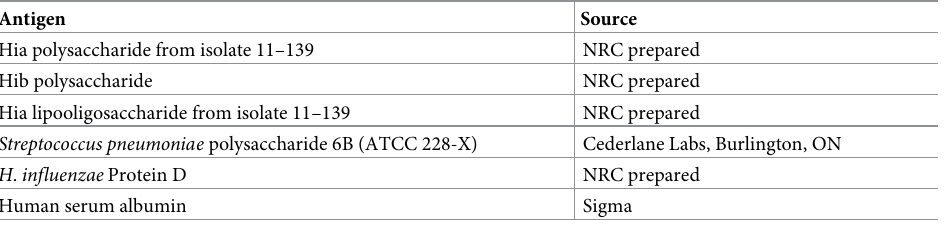
Table 3. Antigens used to absorb pooled human